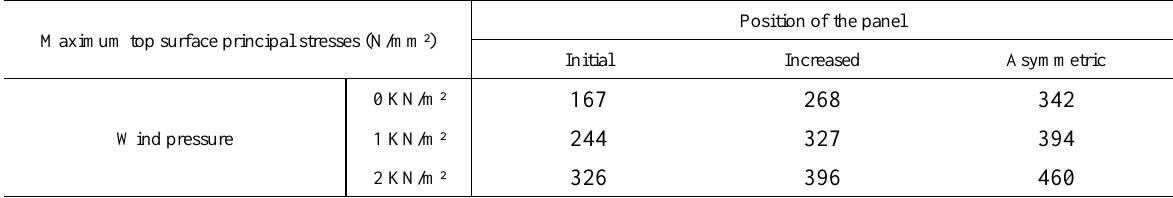
Table 4: Maximum top surface principal stresses in N/mm² according to wind pressure and position of the panel. Glass plate characteristics: thickness: 2.0 mm / dimensions: 1500 x 3000